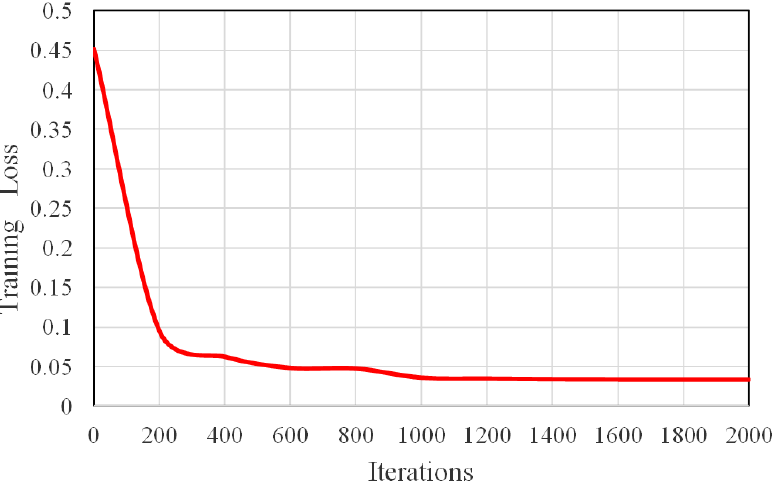
Figure 4. Training loss